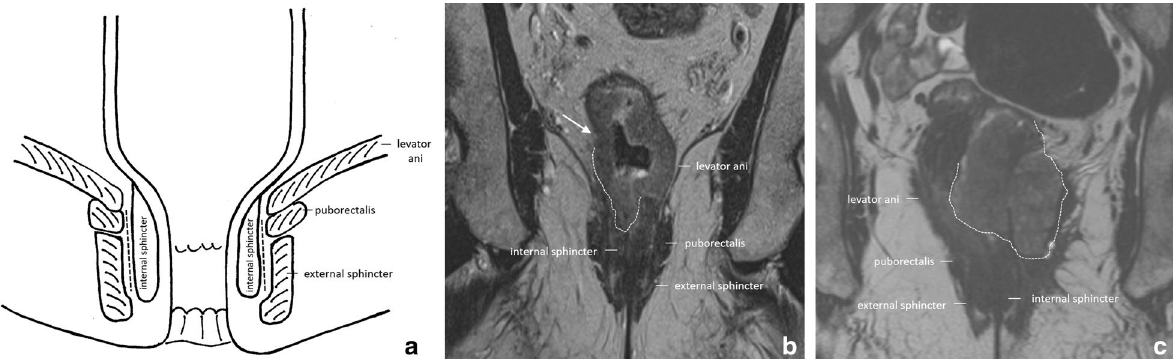
Fig. 5 Schematic coronal drawing a showing the different layers of the anal canal and pelvic floor. The dotted line represents the intersphincteric plane. The coronal T2‑weighted MRI in b is an example of a 62 year old male patient with a cT3a tumour (white arrow showing an irregular rectal wall with 1 mm perirectal extension) that extends into the anal canal and invades the right internal anal sphincter. The coronal image in c is an ± example of a 59‑year‑old female patient with a cT4b rectal tumour that invades the internal sphincter on both sides and extends into the external sphincter, levator ani, and puborectalis muscles on the left